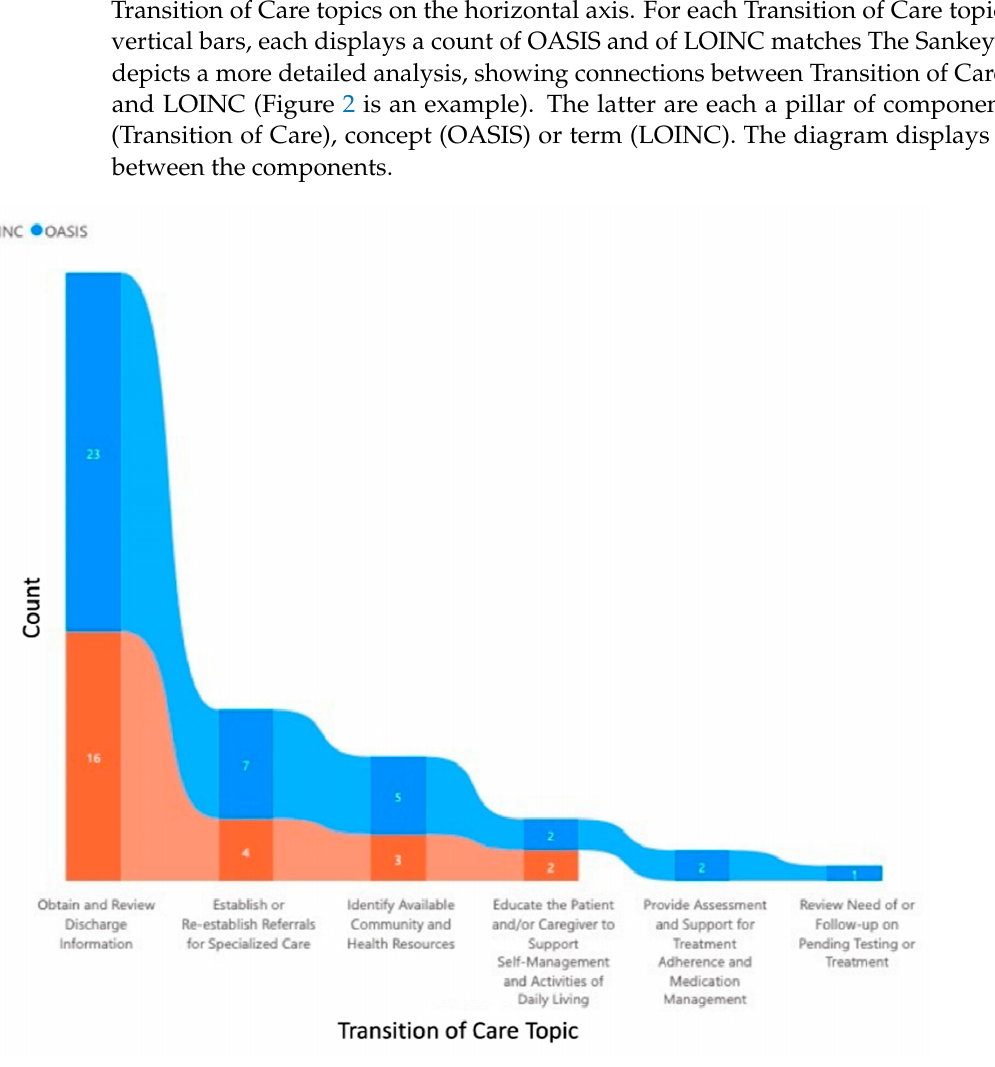
Figure 2. Sankey Diagram Illustrating Linkages Among Transition of Care Topics, OASIS Concepts, and LOINC Codes.